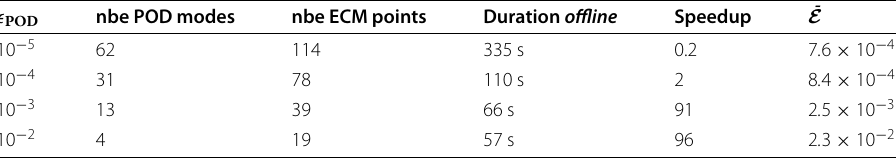
Table 4 Industrial application (comparison of the ROM performances for various values of (cid:3) POD